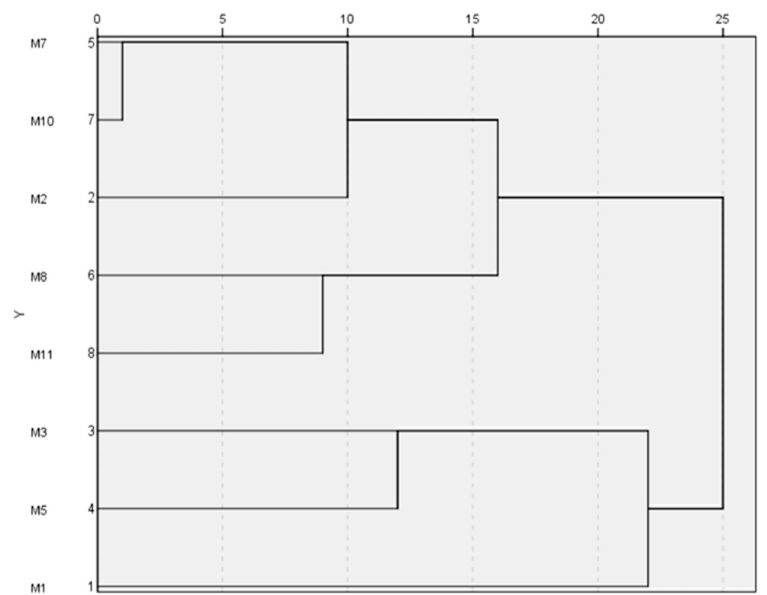
Figure 1. Dendrogram representing the di ff erences among the di ff erent studied accessions based on hierarchical cluster analysis (HCA) of ampelographic characterization employing an average link between groups and re-scaled distance cluster